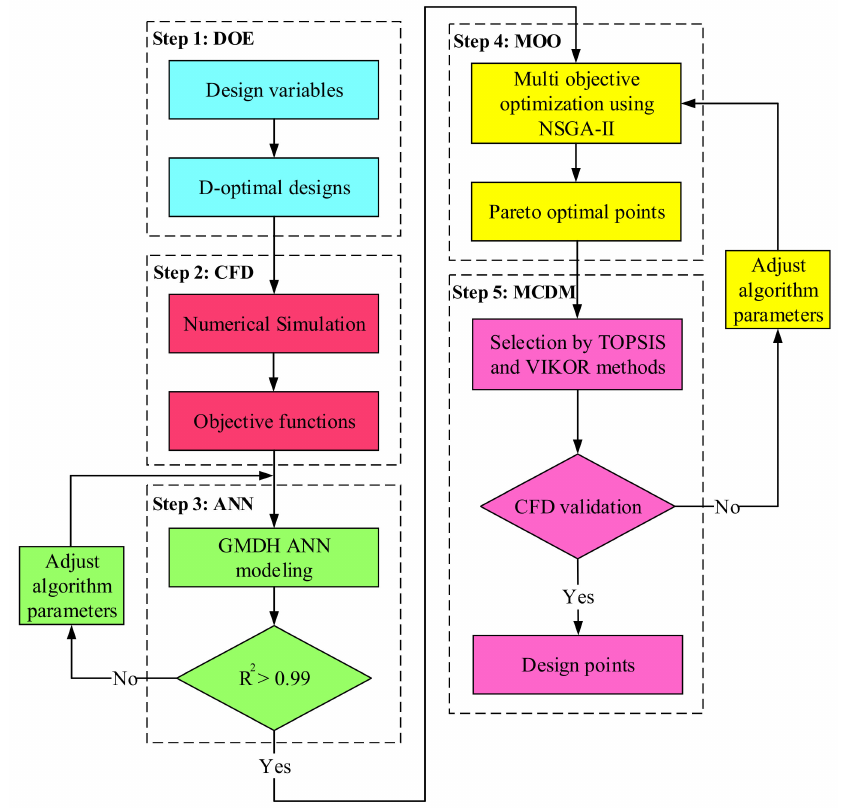
Figure 1. Flow chart of the hybrid optimization procedure in the present